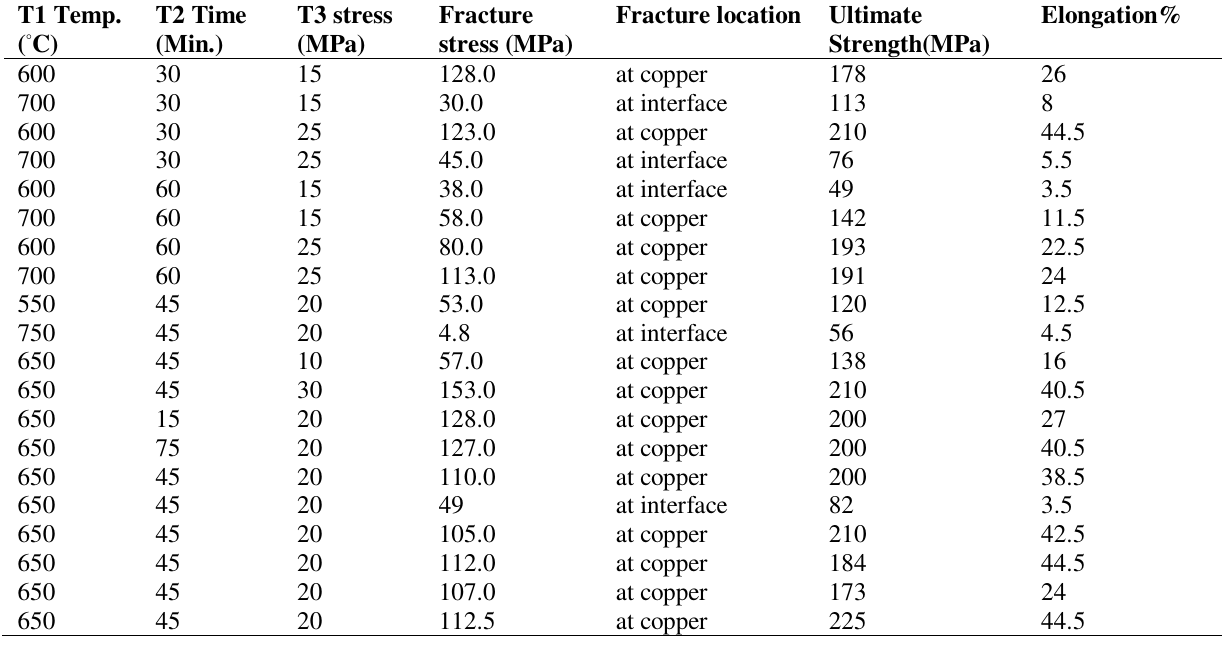
Results of tensile tests of bonding joints.